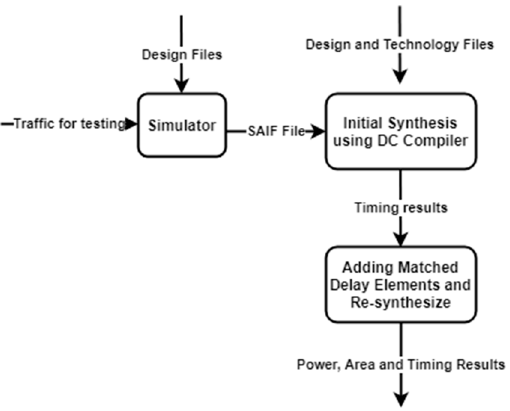
Figure 8. The flow chart used for the simulation and synthesis flow for the NoC’s evaluation.